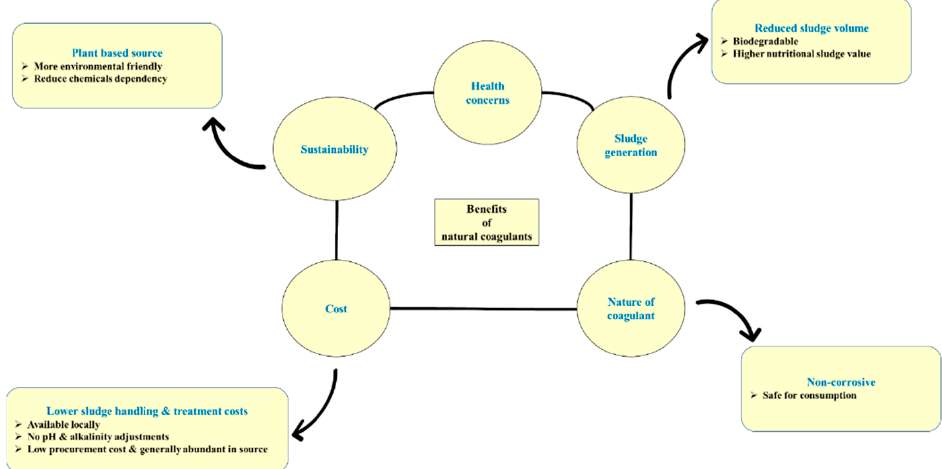
Figure 1. Advantages of natural coagulants over chemical ‐ based coagulants.